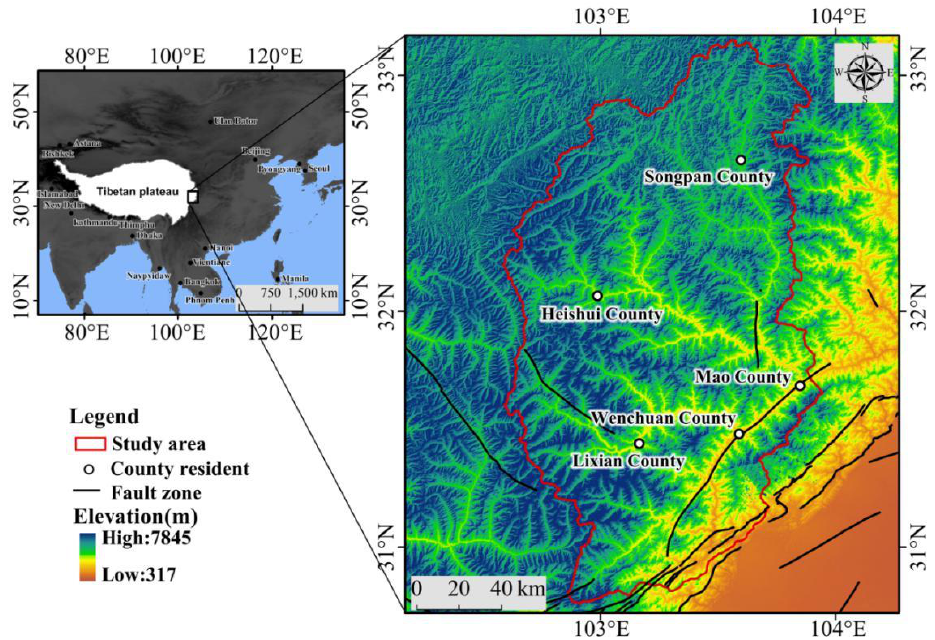
Figure 1. Spatial location of the investigated watershed.